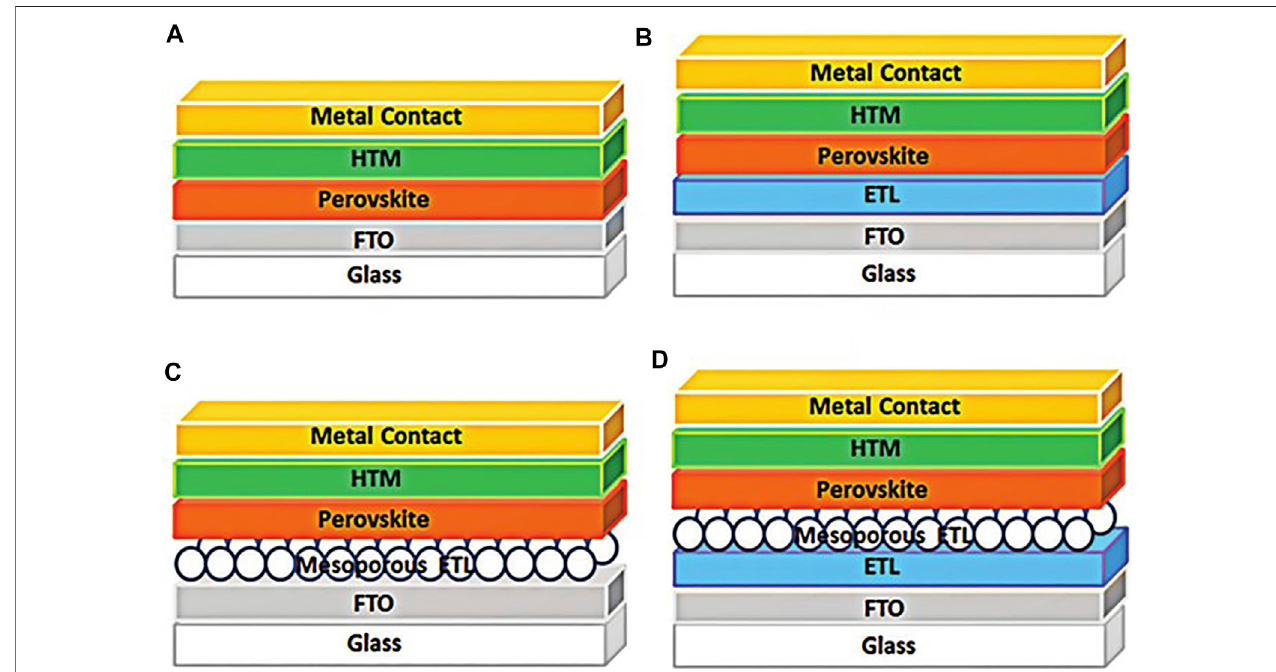
FIGURE2| Thetypicalstructuresoftheperovskitesolarcells, (A) theplanarPSCswithoutETL, (B) theplanarPSCswithcompactETL, (C) themesoporousPSCs without compact ETL, (D) the mesoporous PSCs with compact ETL.